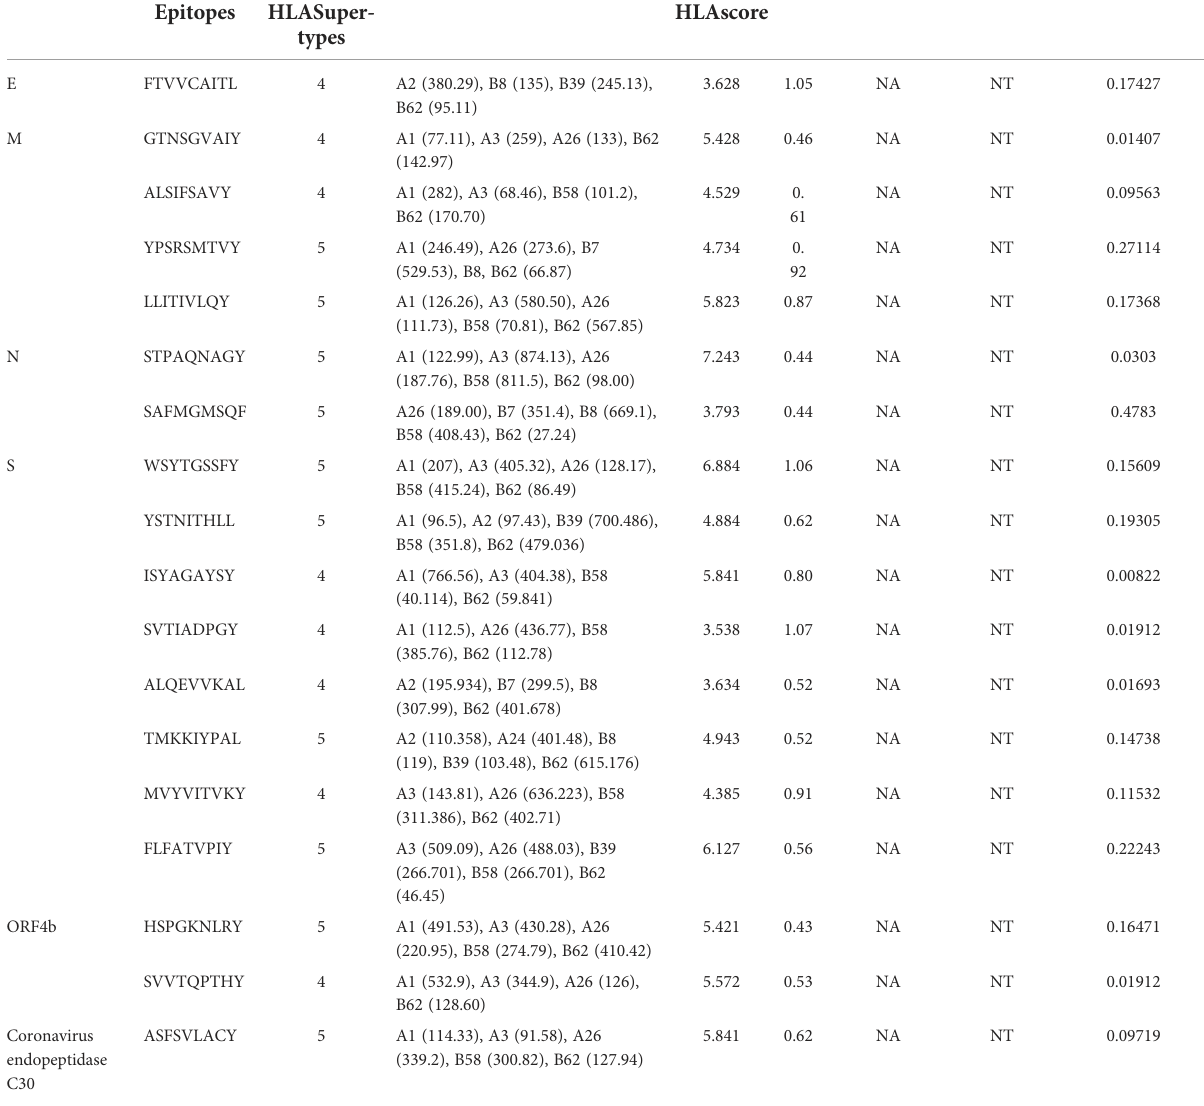
TABLE 3 List of prioritized MHC-I (CTL) binding epitopes by NetCTL 1.2 server. Protein MHC-I No. of Epitopes